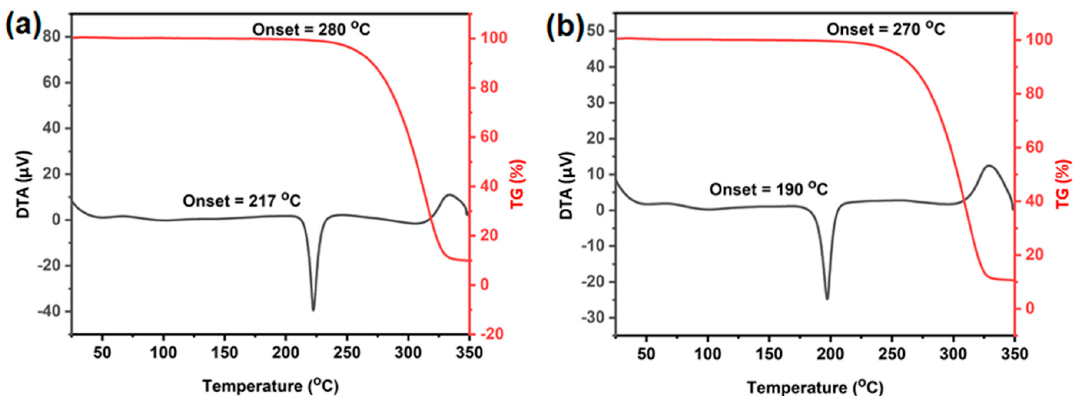
Figure 4. Differential thermal analysis-thermogravimetric (DTA-TG) measurements of ( a ) ACA–BPEE and ( b ) ACA–BPE, respectively. The DTA signals (black) of the cocrystal at the onset 217 °C (for ACA–